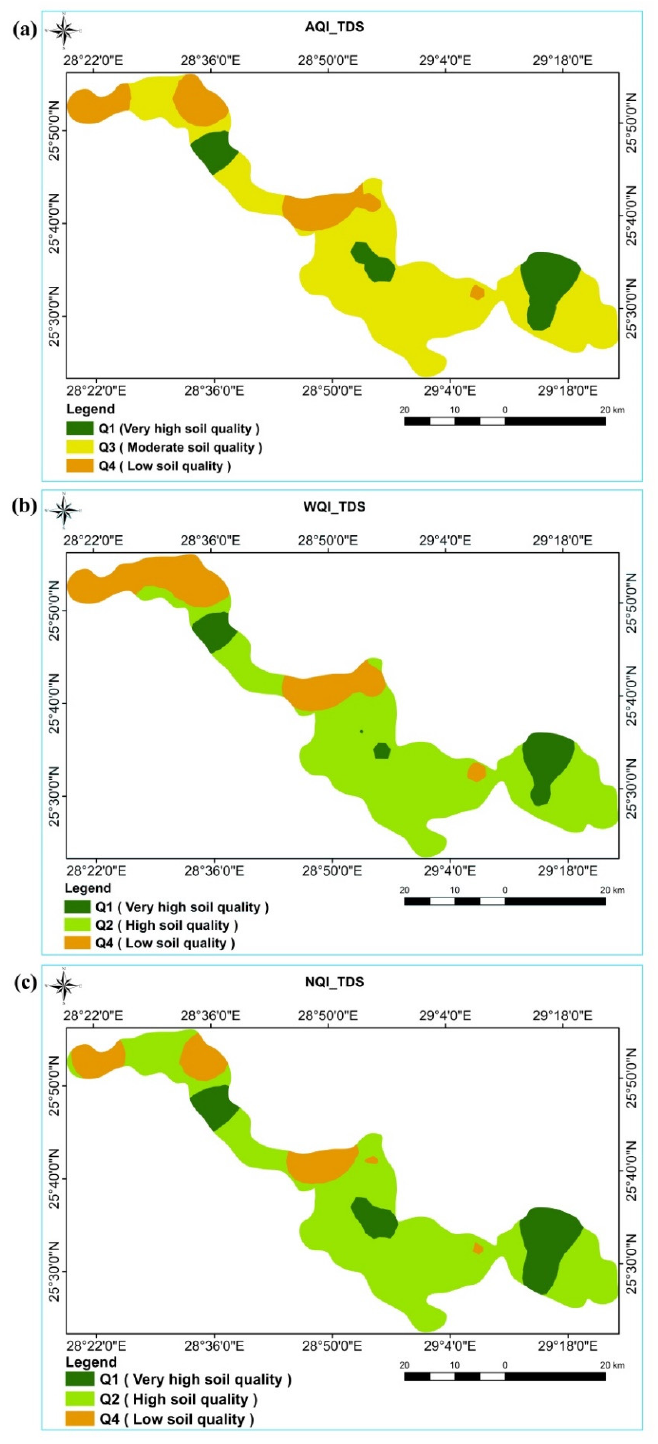
Figure 4. Soil quality grades based on total data set (TDS): ( a ) Additive quality index (AQI); ( b ) Weighted quality index (WQI); and ( c ) Nemoro quality index (NQI).